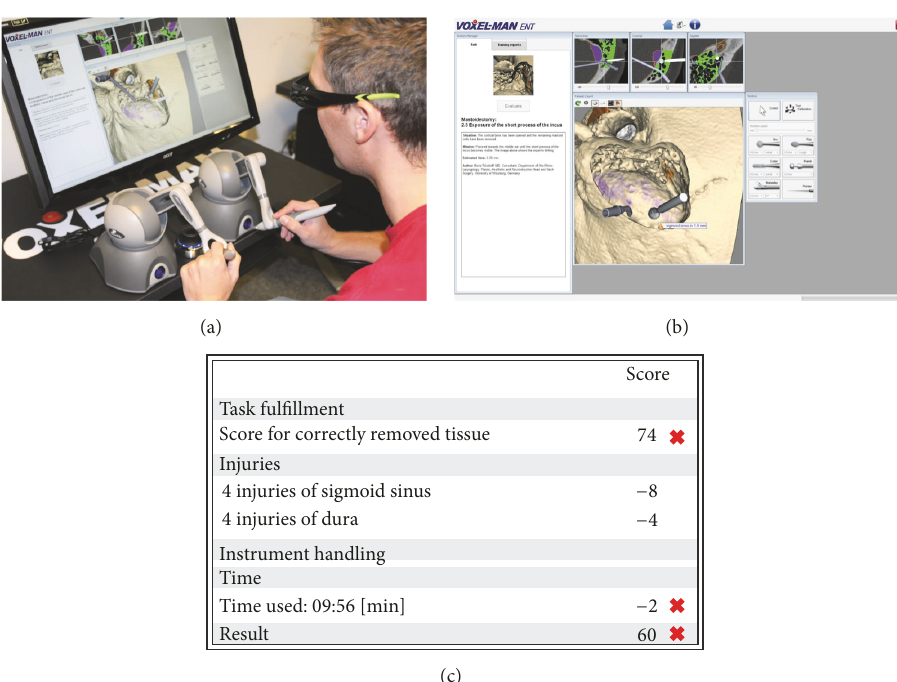
Figure 1: (a) Experimental design, (b) first-person view, and (c) automatic performance metrics generated by the Voxel-Man TempoSurg simulator.